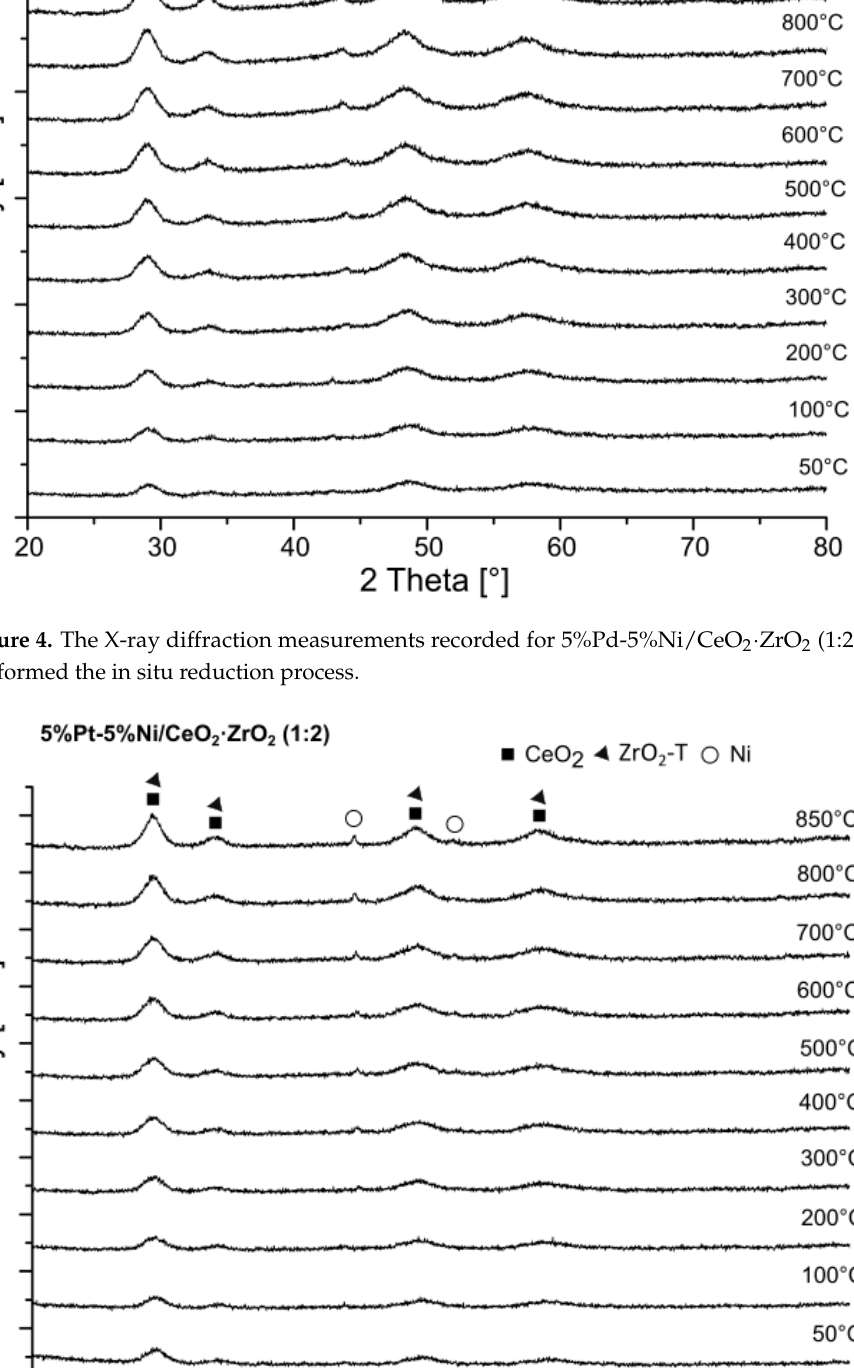
Figure 6. The X ‐ ray diffraction measurements recorded for 5%Ru ‐ 5%Ni/CeO 2 ∙ ZrO 2 (1:2) catalyst performed the “in situ” reduction process.